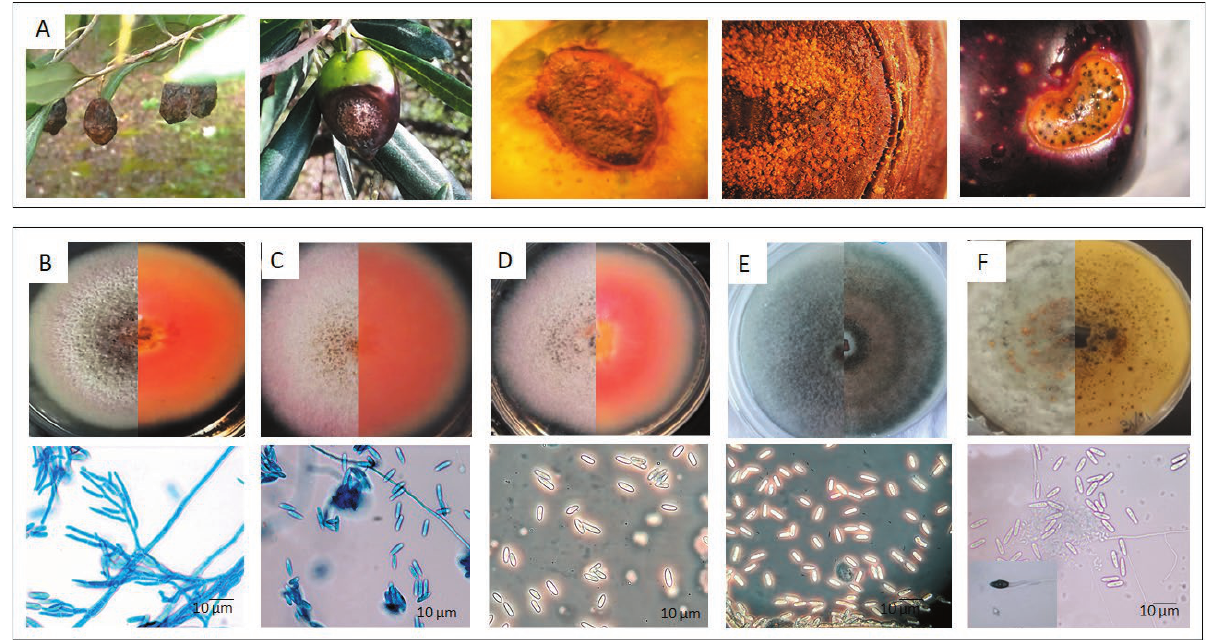
Figure 1. Symptoms of anthracnose (i.e. mummified fruits on the tree, rot, circular sunken lesions) found in olive fruits of the International Olive Germplasm Collection (IOGC) at Villa Zagaria (Sicily, Italy) (A). Above and below views of colony morphology of PDA cultures (top), and respective conidia or conidiophores (bottom) of Colletotrichum acutatum P185 (B), C. acutatum B13-16 (C), C. acutatum P77 (D), C. gloeosporioides C2.1 (E), and C. cigarro Perg6B